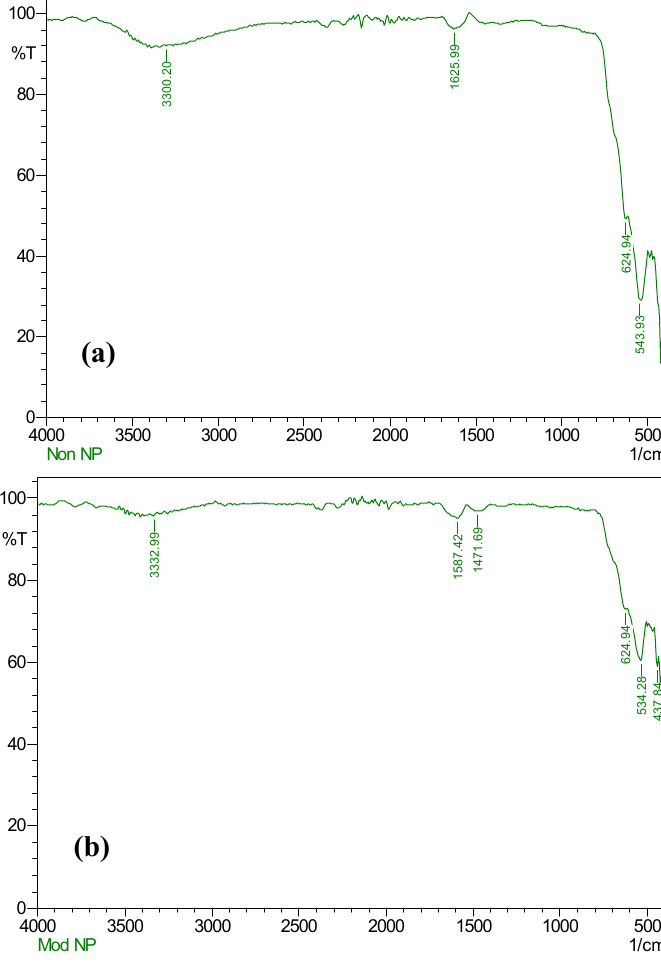
Figure 1. ( a ) Fourier transform infrared spectrophotometer (FTIR) analysis for maghemite nanoparticles (NPs). ( b ) FTIR analysis for modified maghemite nanoparticles (MNPs).